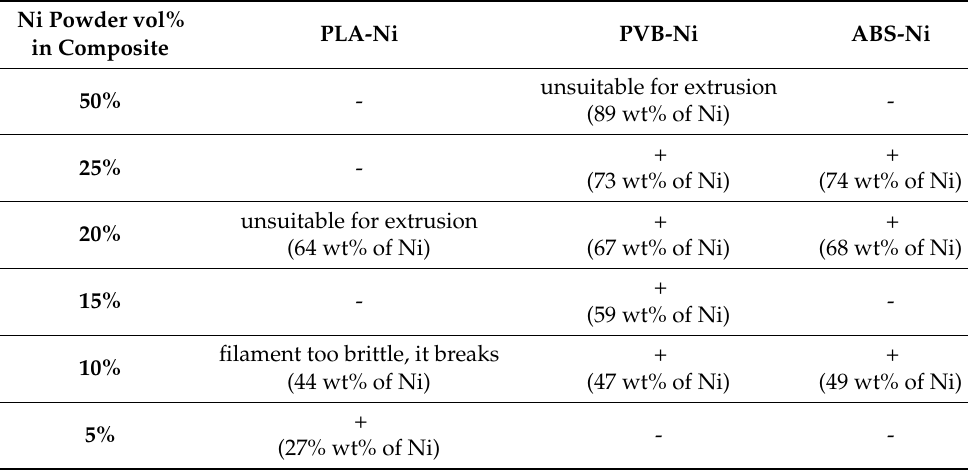
Table 4. Prepared composites and their corresponding